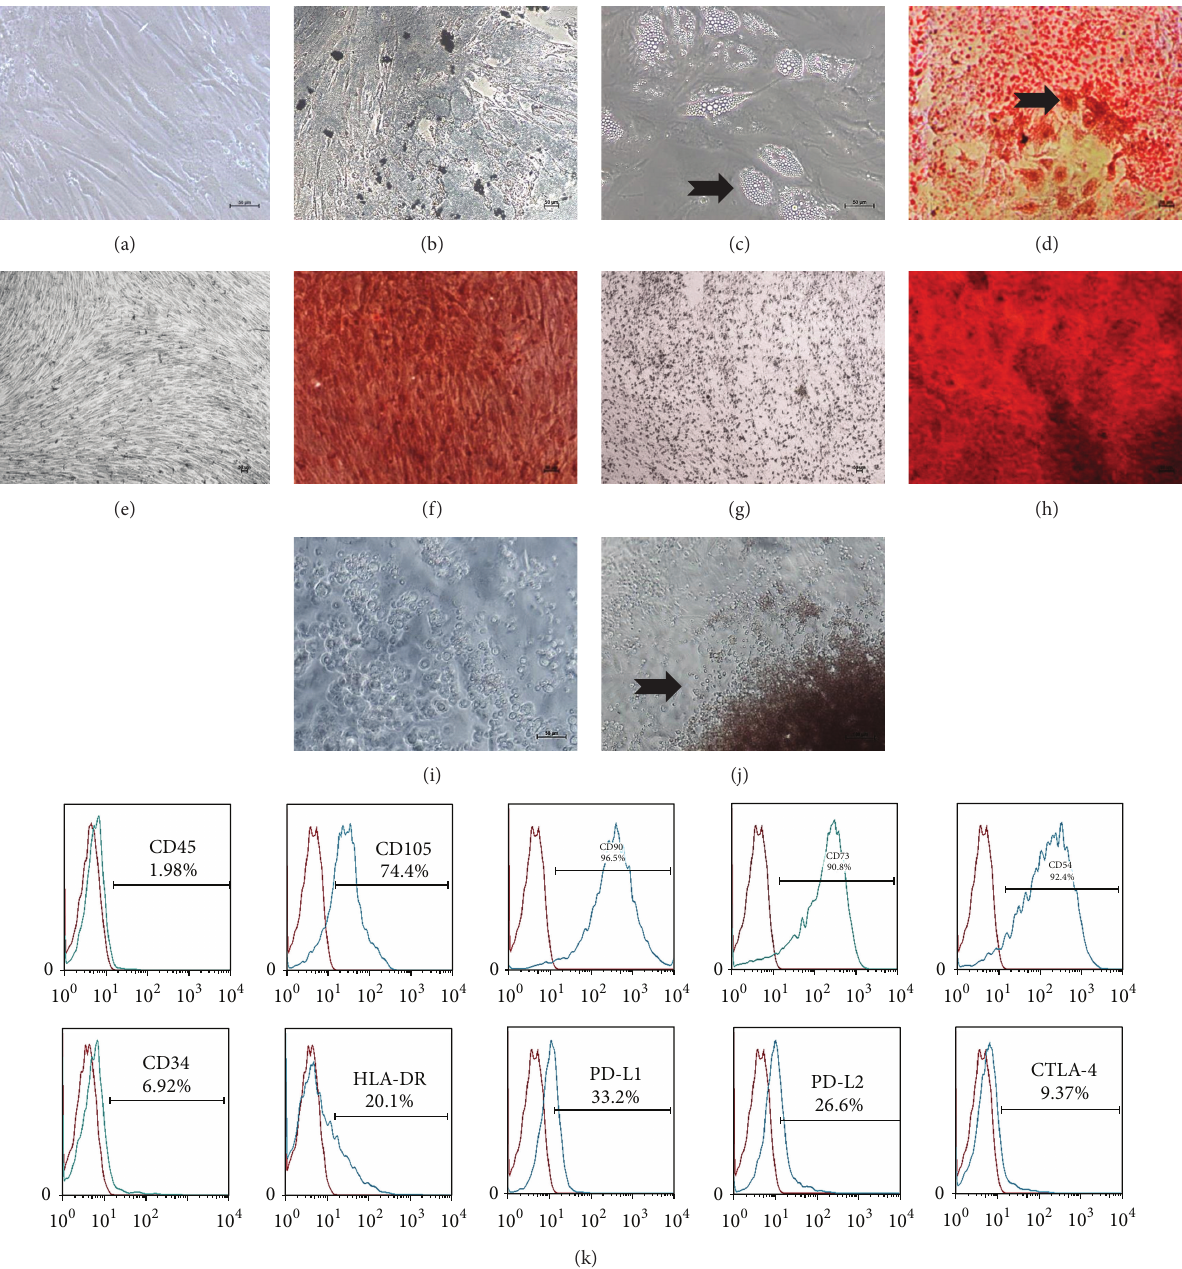
Figure 1: Characterization of bone marrow-derived mesenchymal stem cells and polyp-derived cells. (a) MSCs exhibiting fibroblastic-like morphology in vitro ; (b) MSC culture in adipogenic control medium showing absence of lipid vesicles; (c) MSCs containing lipid vesicles (blackarrow)inadipogenicdifferentiationmediumwithoutOilRedstain;(d)MSCcultureinadipogenicdifferentiationmediumstainedwith Oil Red (black arrow); (e) MSC culture in chondrogenic control medium; (f) MSC culture in chondrogenic differentiation medium stained with Safranin O; (g) MSC culture in osteocyte control medium; (h) MSC culture in osteogenic differentiation medium stained with Alizarin Red; ((i)-(j)) representative view of polyp-derived cells spreading and growing in culture (black arrow); and (k) immunophenotypic signature of MSCs in culture, demonstrating absence of hematopoietic (CD45 and CD34) and immunogenic (HLA-DR) markers and expression of CD105, CD90, CD73, and CD54, as well as immunoregulatory receptors such as PDL-1 and -2 and